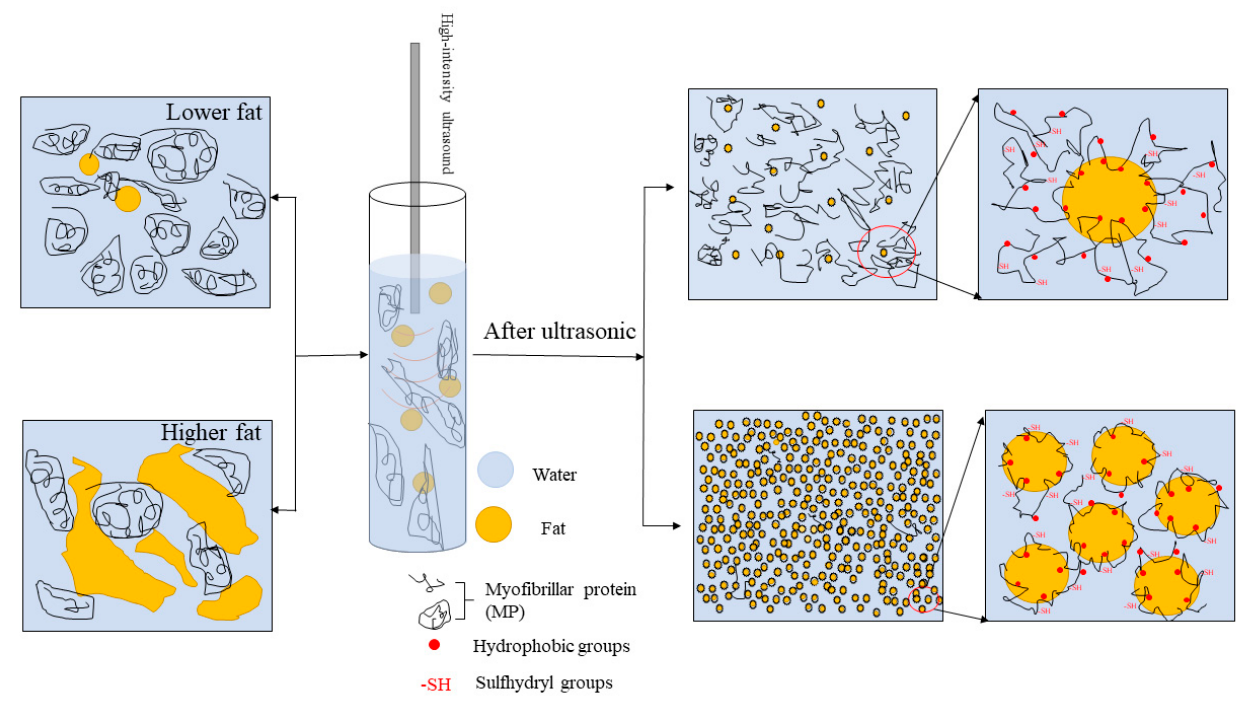
Figure 6. Schematic diagram illustrating the improvement of MP pork fat emulsion properties with high-intensity ultra- sound emulsification.